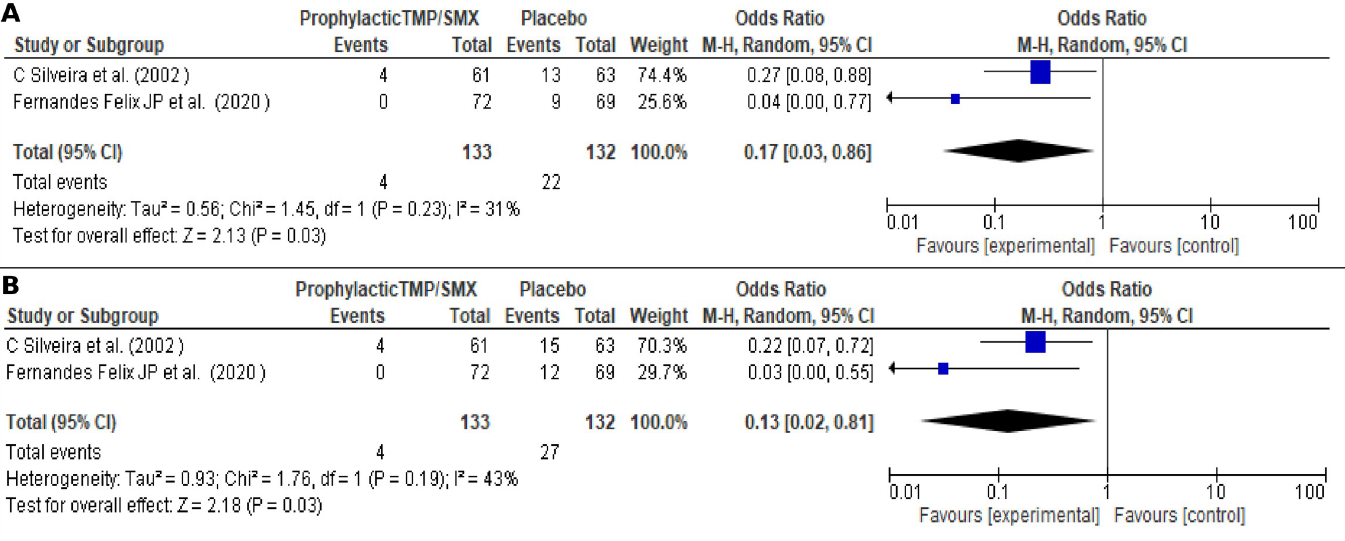
Fig 9. Effect of the prophylaxis on the recurrences. (A). Reduction in recurrence with prophylaxis in the first year, (B). Reduction in recurrence with prophylaxis in the second year.